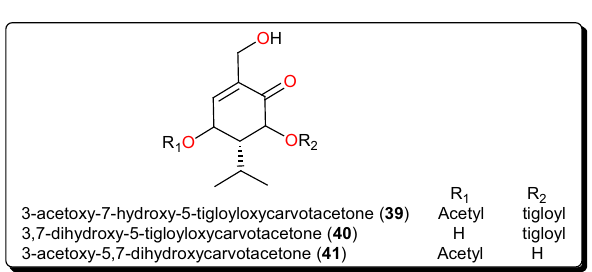
Fig. 7 Carvotacetones with potent antileishmanial activities